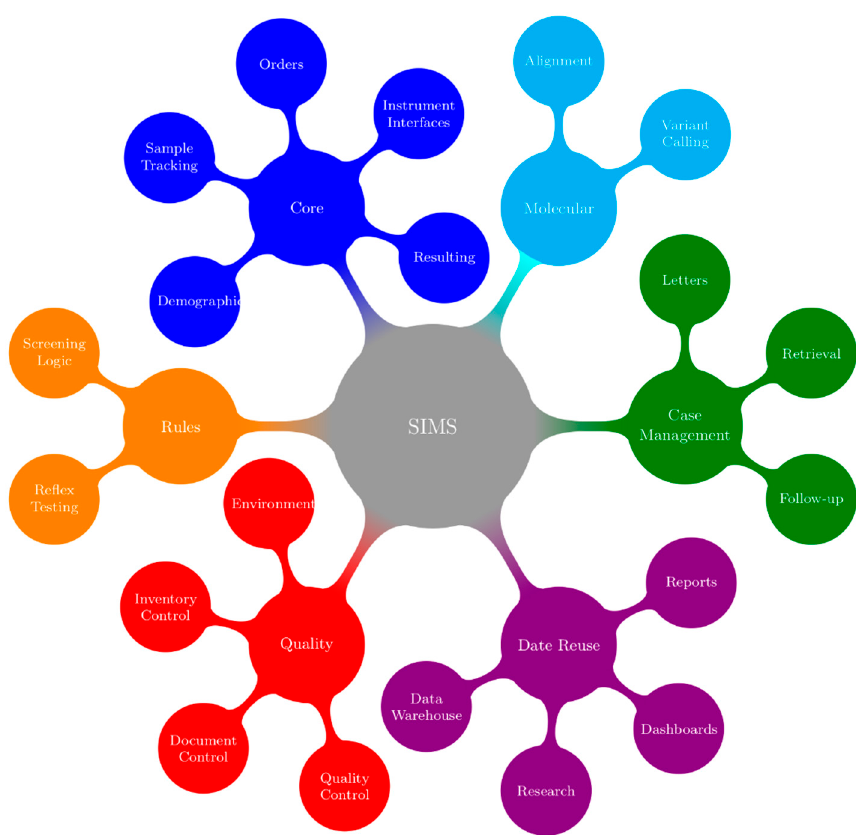
Figure 2. Concepts and Functionality in a SIMS (Screening Information Management System). Each secondary node represents a concept that is addressed by a SIMS. Tertiary nodes show specific examples of SIMS functionally that fall within the linked concept. Colors are used to emphasize the link between concepts and functions.